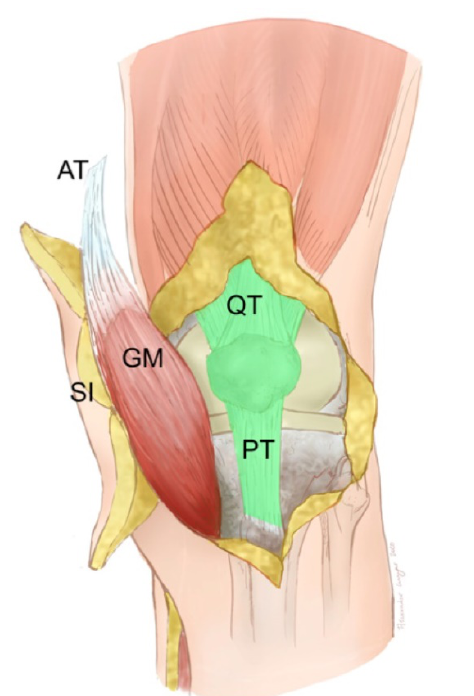
Figure 12: Pedicled MSAP gastrocnemius flap: Clinical scenario of PJI after TKA in a patient who does not qualify for free flap surgery with a soft-tissue defect and an underlying extensor apparatus deficiency with either a partial patellar tendon (PT) lesion or partial quadriceps tendon (QT) lesion (light green). The soft-tissue defect is reconstructed with a MSAP gastrocnemius flap. Shown is the situation after the flap has been guided underneath the intact skin bridge that contains the saphenous nerve and vein. The medial gastrocnemius muscle (GM) has been raised with part of the Achilles tendon (AT) and the overlying skin island (SI) fed by the MSAP (Table 1: Patient No. 5; additional Figures 6, 13, 14, 15, 16,